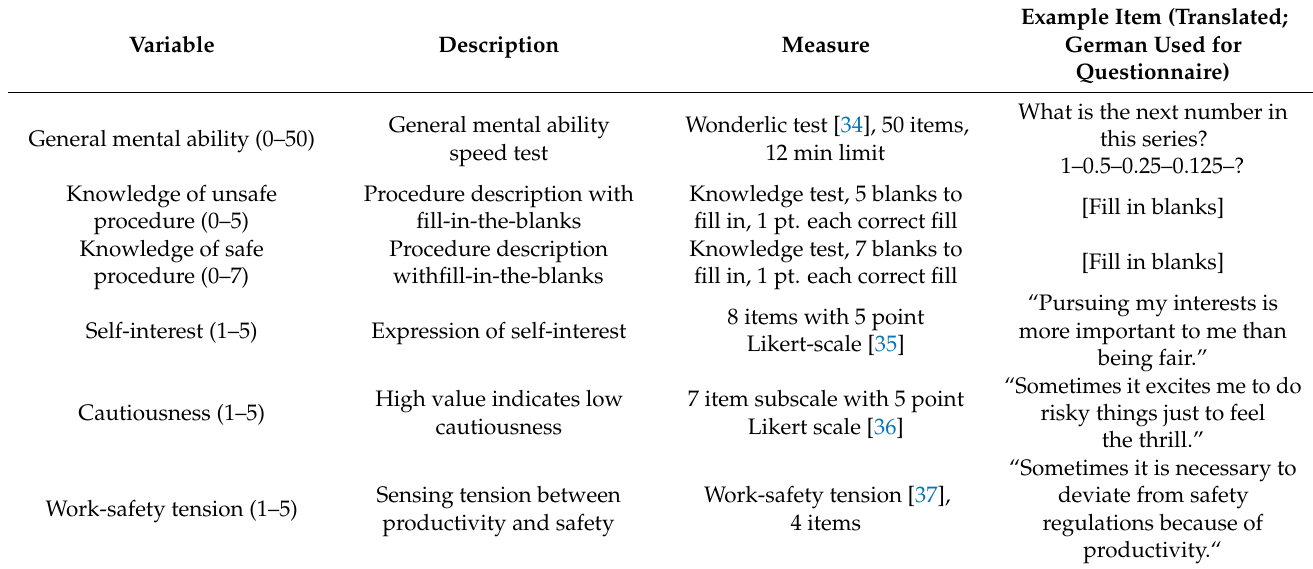
Table 2. Questionnaires used to assess cognitive-, person-, and personality-related aspects as control